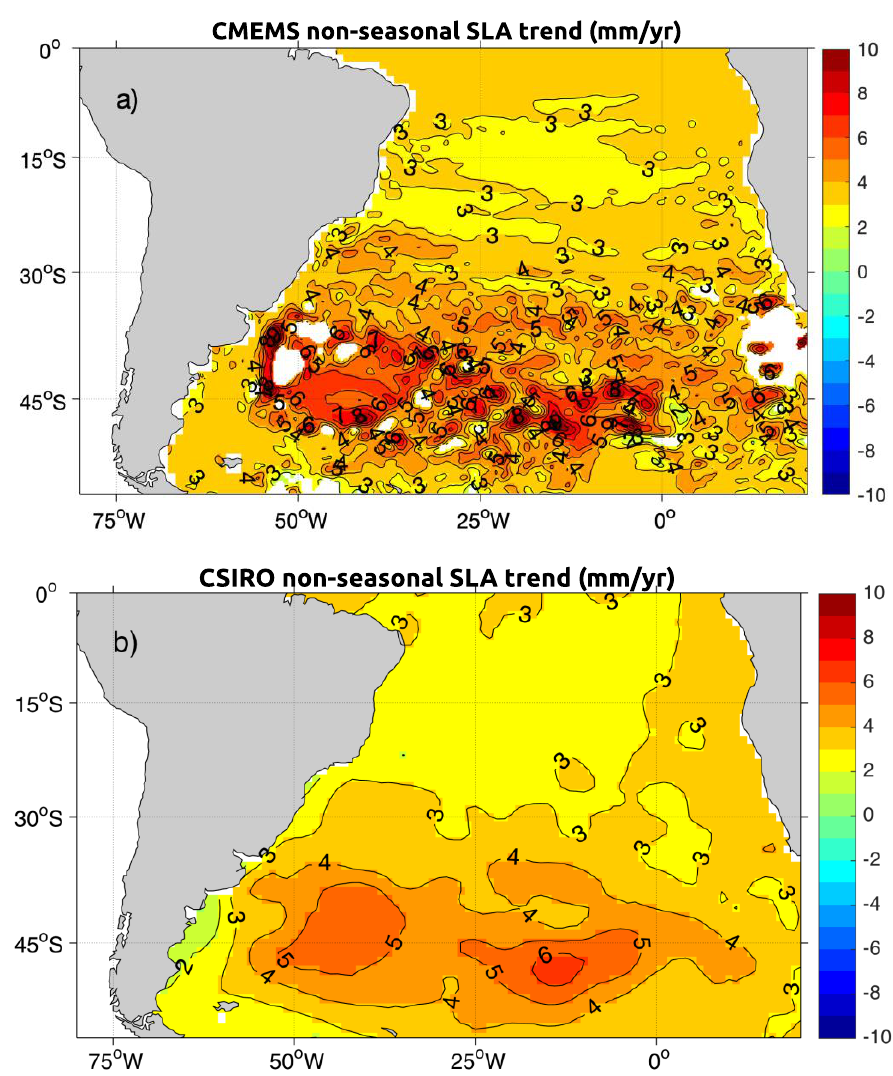
Figure 2. Sea level trend (mm / yr) pattern for ( a ) CMEMS and ( b ) CSIRO for the period January 1993 to December 2017. The white areas mask the non-significant trends. Units: mm / yr.